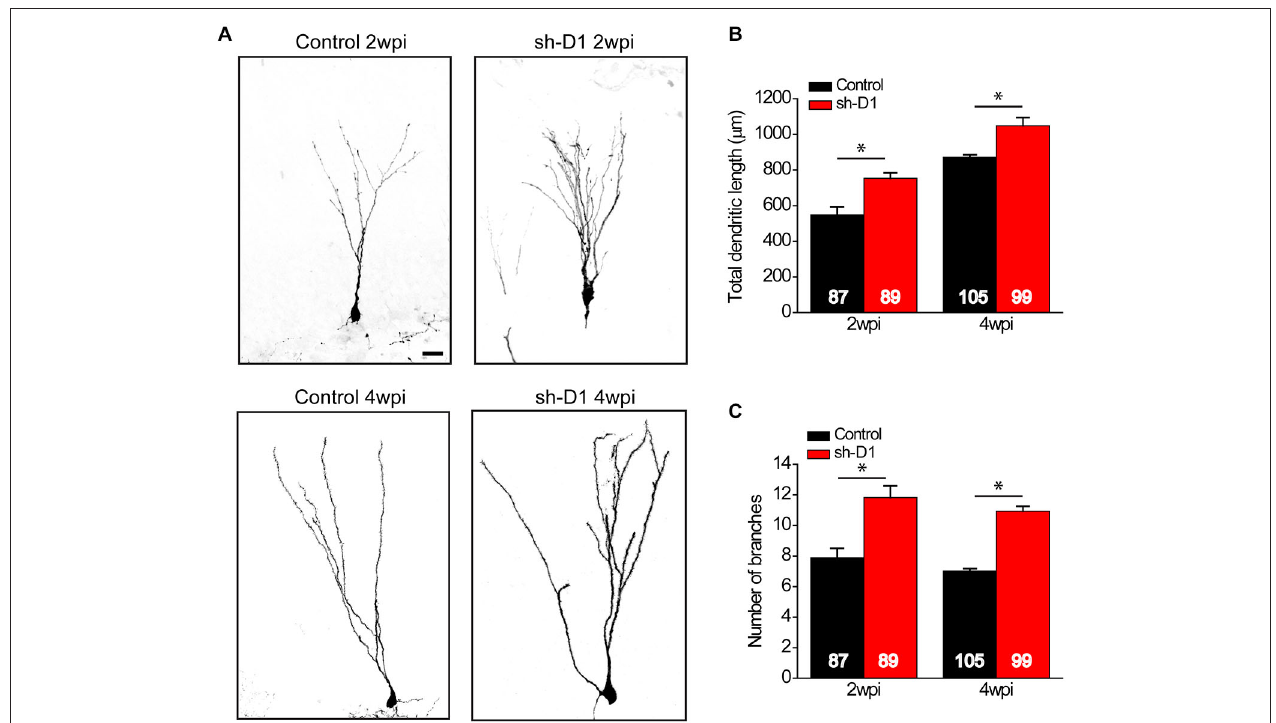
condition. Values represent mean ± SEM (* p < 0.05; Two-way ANOVA; 2 wpi: control, n = 87, sh-D1, n = 89; 4 wpi: control, n = 105, sh-D1, n = 99). (C) Number of branches of GFP + neurons at 2 and 4 wpi. Values represent mean ± SEM (* p < 0.05; Two-way ANOVA; 2 wpi: control, n = 87, sh-D1, n = 89; 4 wpi: control, n = 105, sh-D1, n =